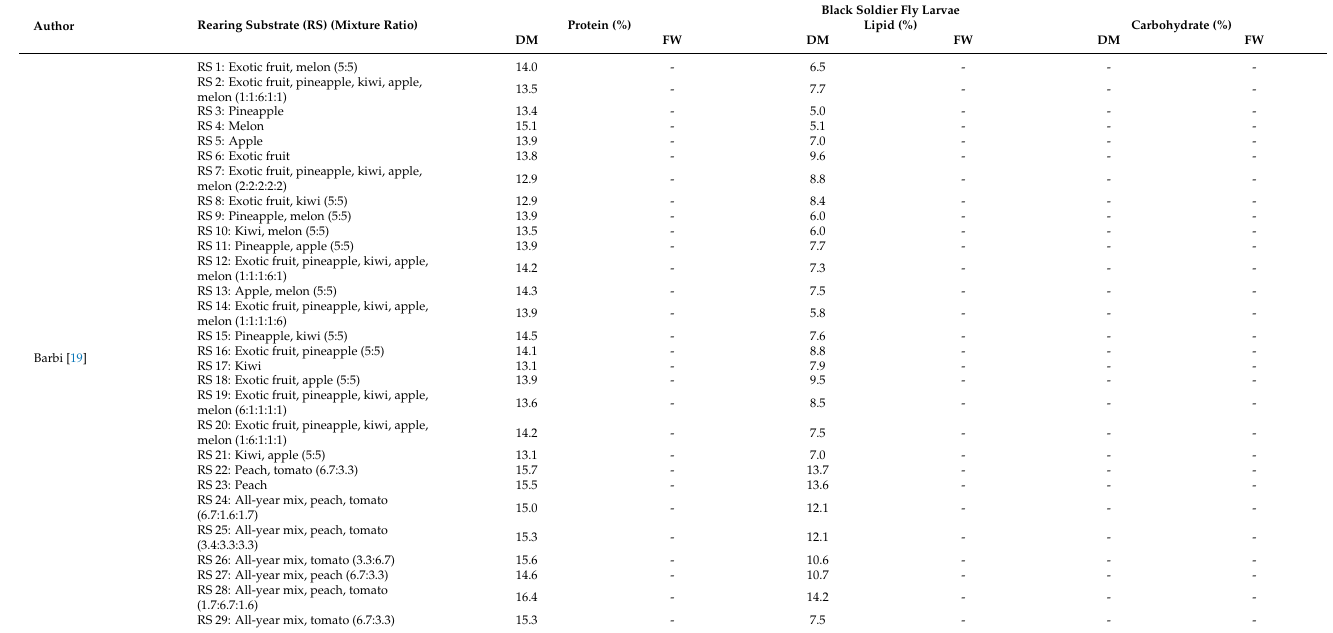
Table 3. Macronutrient Composition of Black Solider Fly Larvae Reared on Food